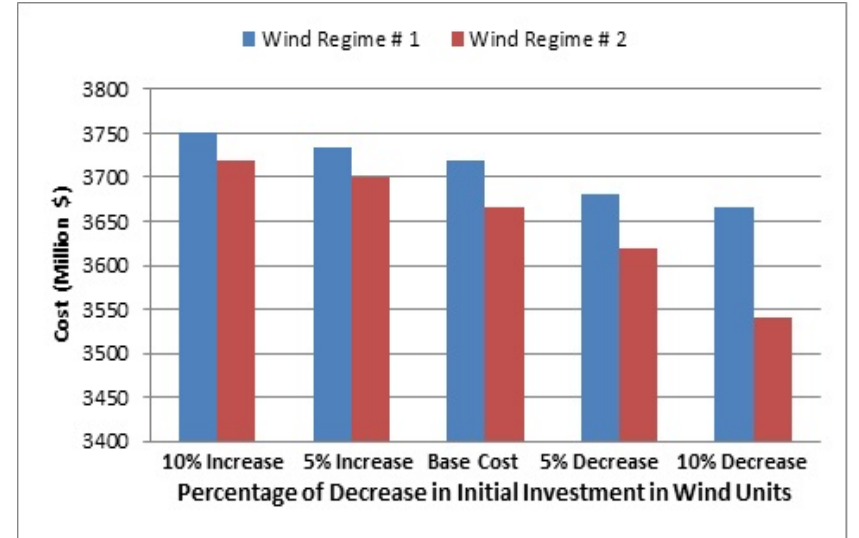
Figure 8. Cost reduction of system operation by increasing wind farm penetration.